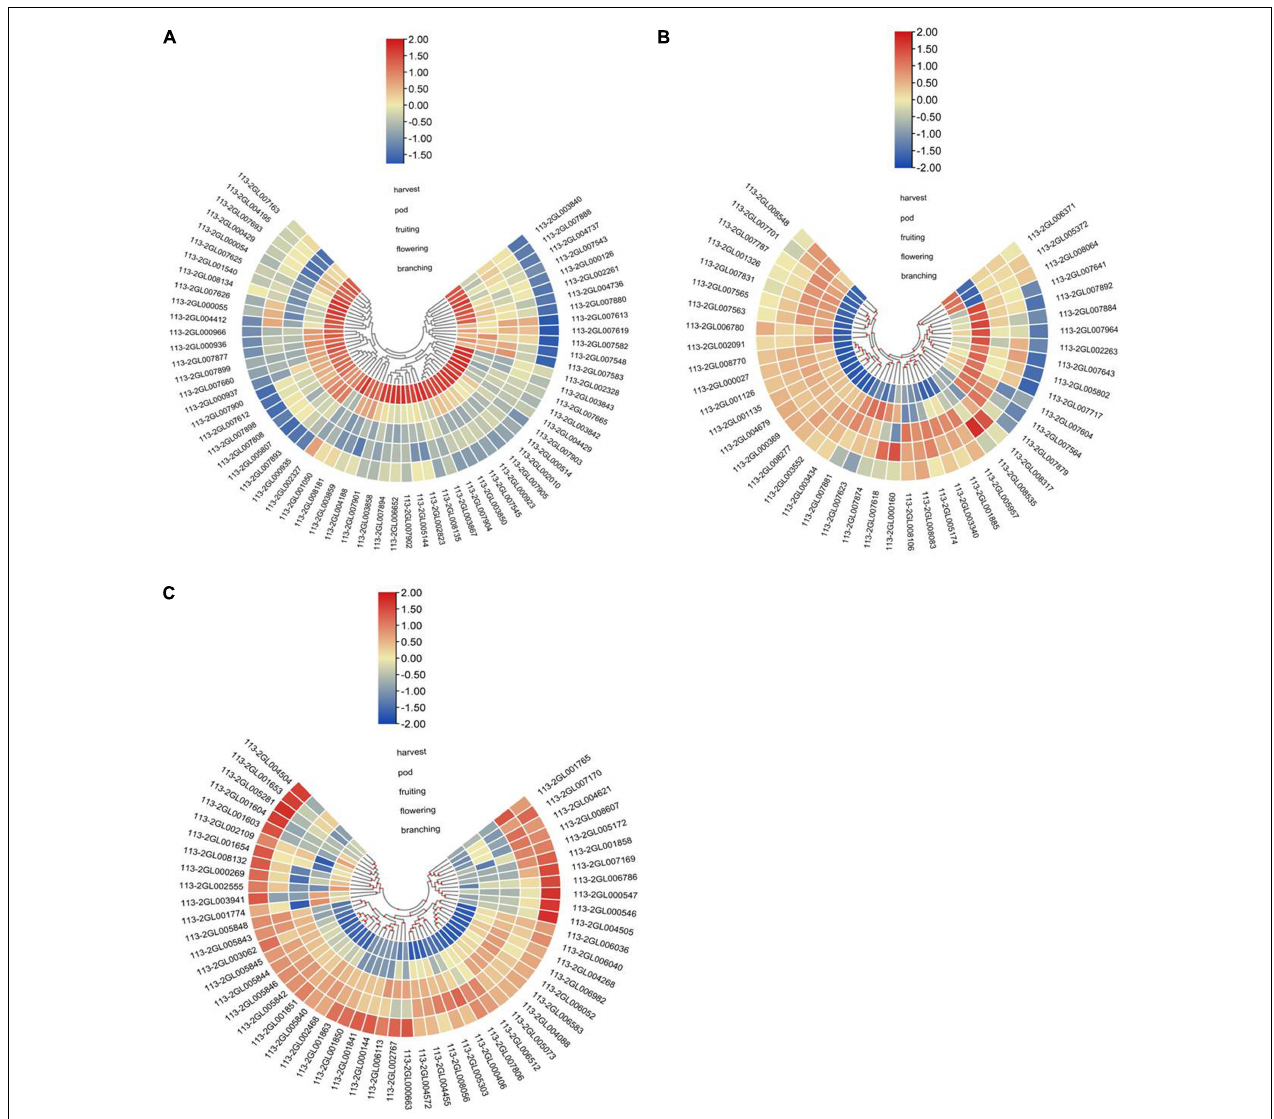
FIGURE 3 | Heatmap plot showing the expression profile of the DEGs during nodule development and senescence. (A) Heatmap of DEGs mainly expressed in early nodule development. (B) Heatmap of DEGs maily expressed in nitrogen fixation progress. (C) Heatmap of DEGs mainly expressed in nodule senescence. These five nodule samples include the nodules at branching stage (1), flowering stage (2), fruiting stage (3), pod stage (4) and harvest stage (5), and the pheatmap packages in R were used to product this